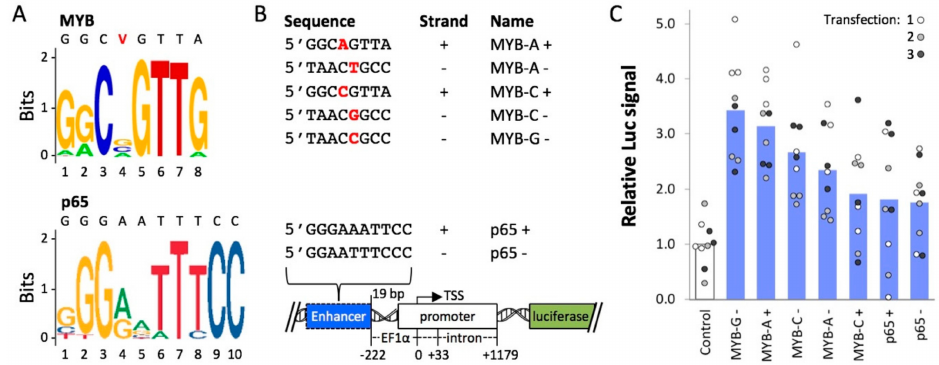
Figure 1. Luciferase expression from MYB- and p65-enhancer constructs. ( A ) Enhancer motif logos for MYB and p65 were generated by JASPAR [57]. The MYB sequence includes a variable site (V) equally represented by A, C, or G nucleotides, shown in red font. ( B ) Luciferase reporter constructs included one of the enhancer sequences (MYB-A + , etc.) 19 bp upstream of an EF1 α promoter, or no enhancer (Control). ( C ) Luciferase assays were carried out using PC-3 cells transfected with Lipofectamine-plasmid complexes. For each transfection, luminescence (Luc signal) values were measured in triplicate and normalized to the average signal from the Control. Circle = one Luc measurement, bar = mean of nine Luc